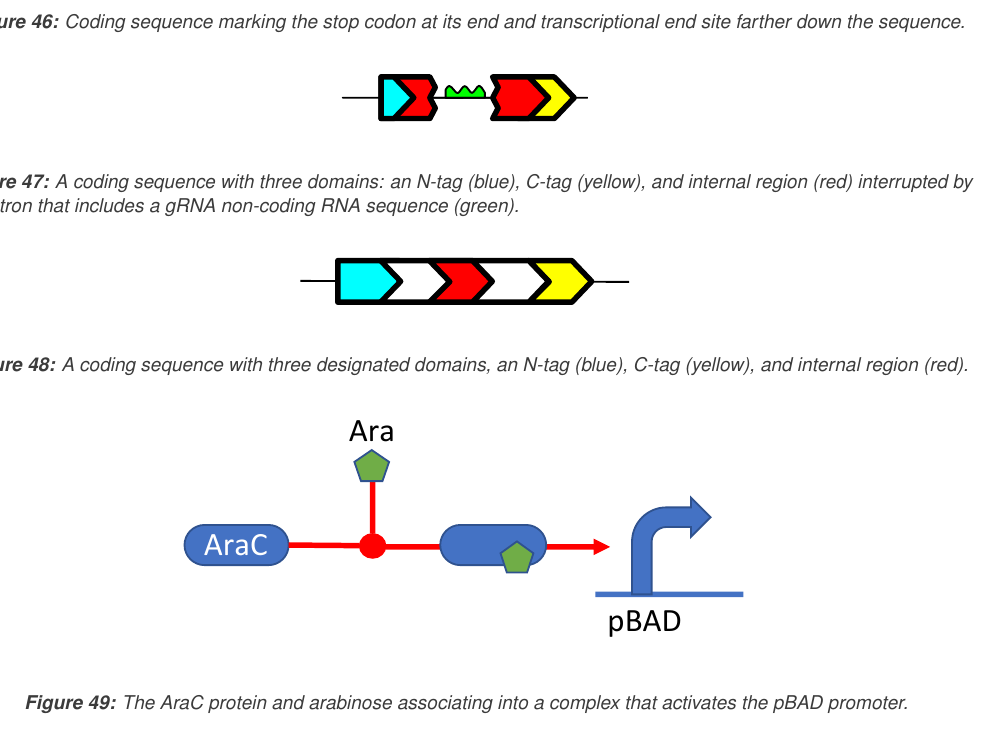
Figure 46: Coding sequence marking the stop codon at its end and transcriptional end site farther down the sequence.